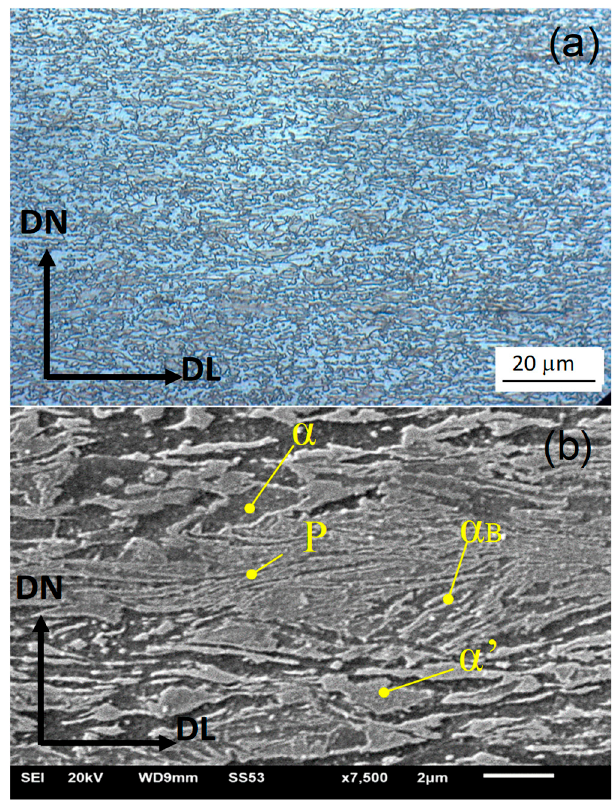
Figure 2. Microstructure of cold-rolled steel sheets, images obtained by: ( a ) optical microscopy and ( b ) scanning electron microscopy.